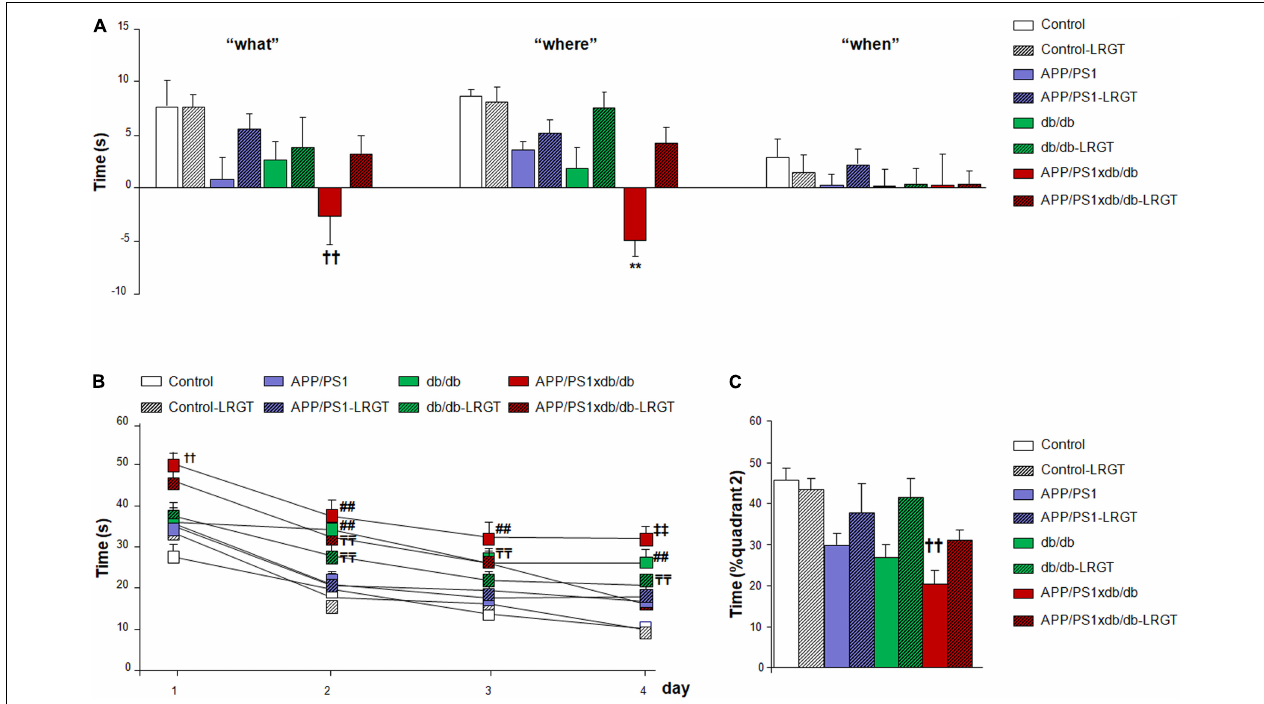
FIGURE 2 | LRGT treatment reduced cognitive impairment in APP/PS1xdb/db mice. Control, APP/PS1, db/db, and APP/PS1xdb/db animals were analyzed in the new object discrimination test for “what,” “when,” and “where” paradigms (A) as well as in the (B,C) Morris water maze test. Behavioral assessment commenced on week 24, after 18 weeks of LRGT treatment (500 µ g/kg/day), and was completed on week 26 (complete statistical analysis included as a Supplementary Material ). (A) LRGT improved episodic memory in the new object discrimination test. No differences were observed for the “when” paradigm; however, significant improvement was observed for the “what” ( †† p = 0.009 vs. Control, Control-LRGT, and APP/PS1-LRGT) and “where” (** p < 0.001 vs. rest of the groups) paradigms. (B) LRGT also improved the performance along the acquisition phase in the MWM ( †† p < 0.01 vs. Control, Control-LRGT, APP/PS1, APP/PS1-LRGT, db/db, and db/db-LRGT; ## p < 0.01 vs. Control, Control-LRGT, APP/PS1, and APP/PS1-LRGT; p < 0.01 vs. Control and Control-LRGT; p < 0.01 vs. Control, Control-LRGT, APP/PS1, APP/PS1-LRGT, db/db-LRGT, and APP/PS1xdb/db-LRGT). (C) In the retention of the MWM, we observed that LRGT treatment also improved the performance of APP/PS1xdb/db-LRGT mice ( †† p = 0.002 vs. Control, Control-LRGT, and db/db-LRGT) (complete statistical analysis included in Supplementary Material ). Data are representative of 5–12 animals, and differences were detected by one-way ANOVA followed by Tukey’s b or Tamhane